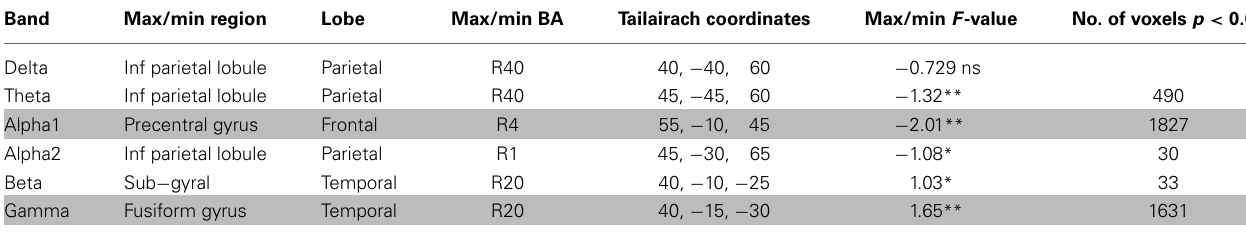
Table 1 | SYT > SYS comparison for Meditation 1—(Body-steadiness).